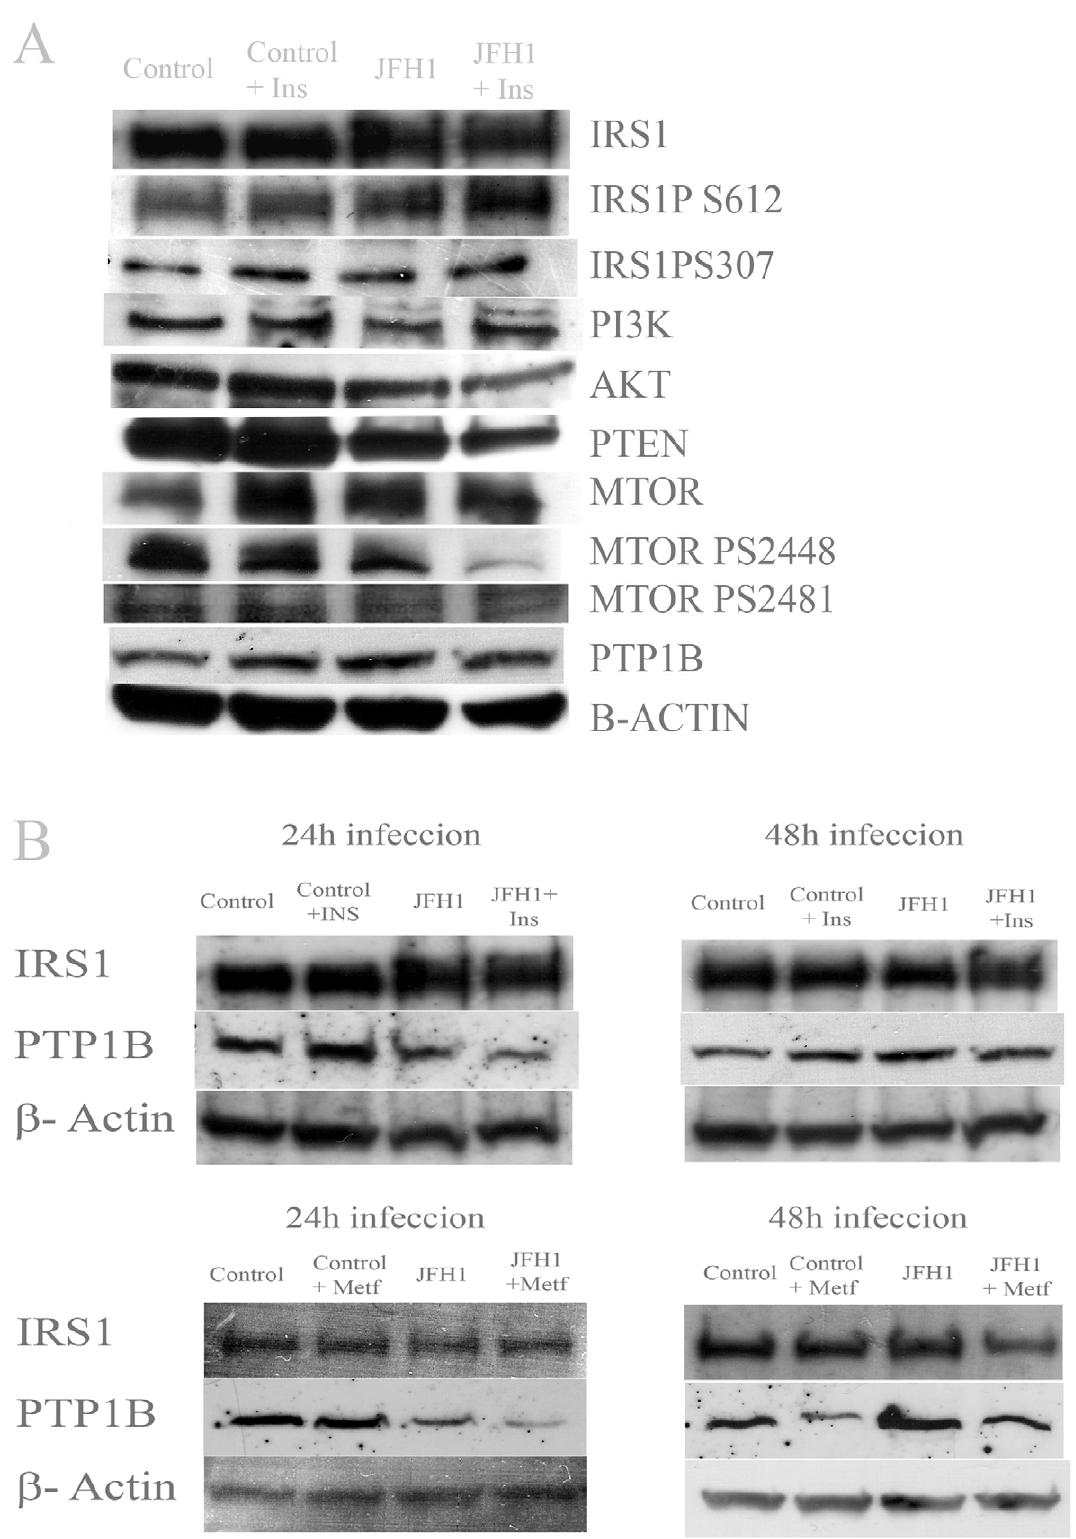
Figure 4. Insulin pathway proteins are down-regulated by JFH1. A : Western blot from Huh7.5 cells in the presence or absence of insulin (20 nM) and infected or not with JFH-1 particles. 40 m grams of total protein were loaded per lane. A representative gel is shown for each protein. All experiments were performed in triplicate. b -Actin was used as a loading control. B : IRS1 and PTP1B abundance at 24 and 48 hours post-infection. Huh7.5 cells were infected with JFH1 particles and incubated at the indicated time. Performance of western-blot was as indicated for panel A .